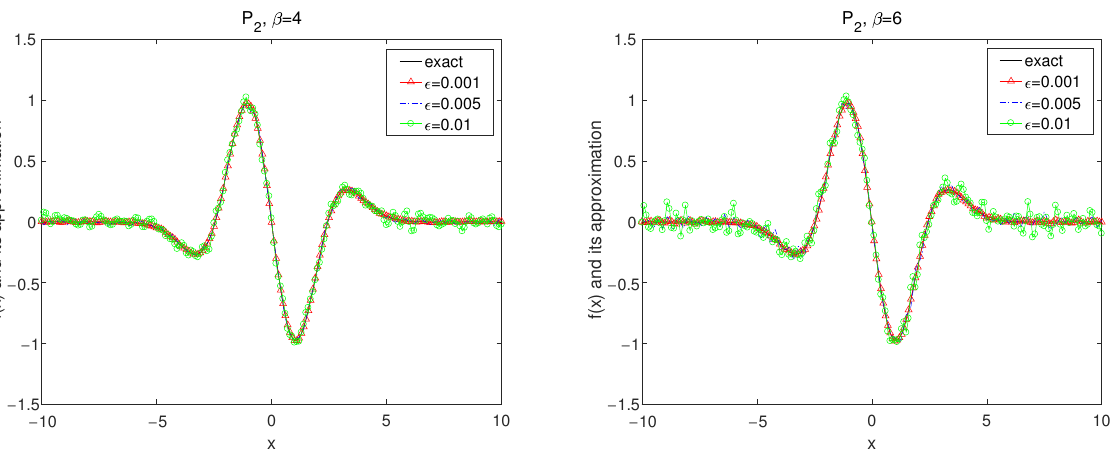
Figure 4. The exact solution and the regularized solutions with β = 4,6 using kernel P 1 under the a posteriori choice rule for Example 1.